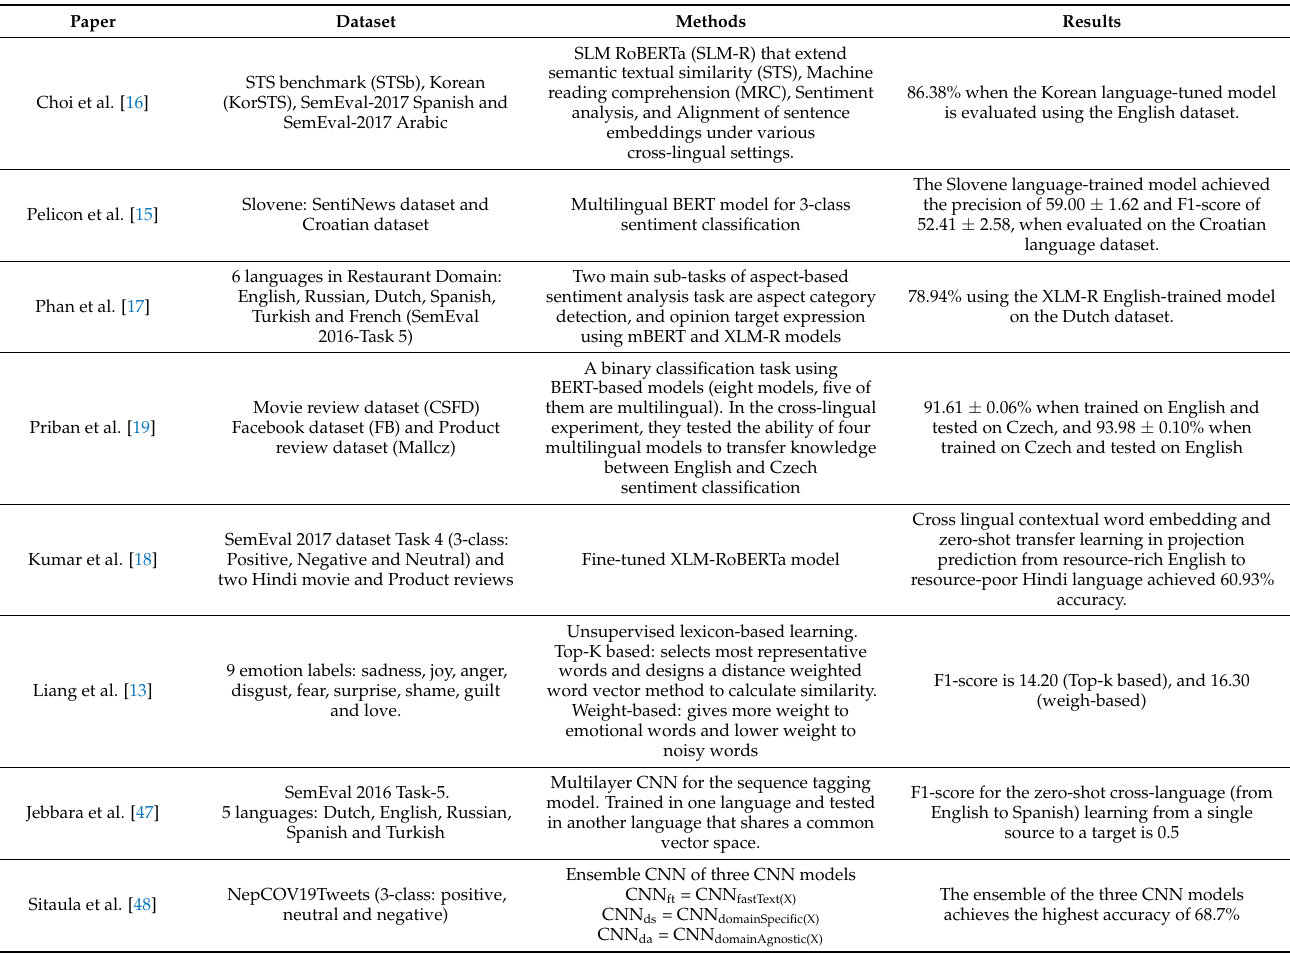
Table 2. Summary of analyzed related works. The papers are compared according to the dataset, methods and results